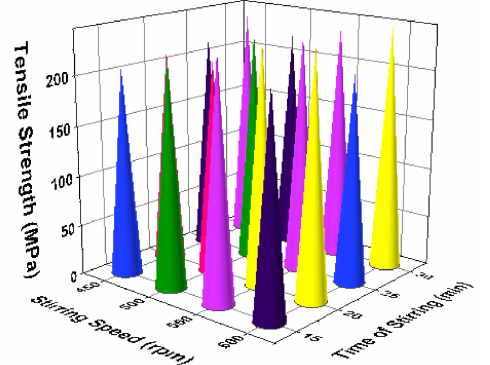
Figure 12. 3D bar plot: stirring speed vs. time of stirring.